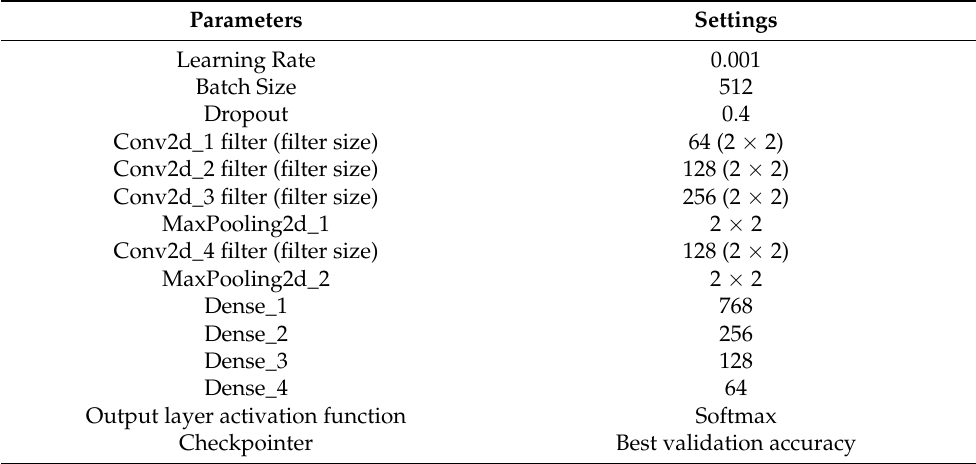
Table 4. Parameter description of CNN model with embedding